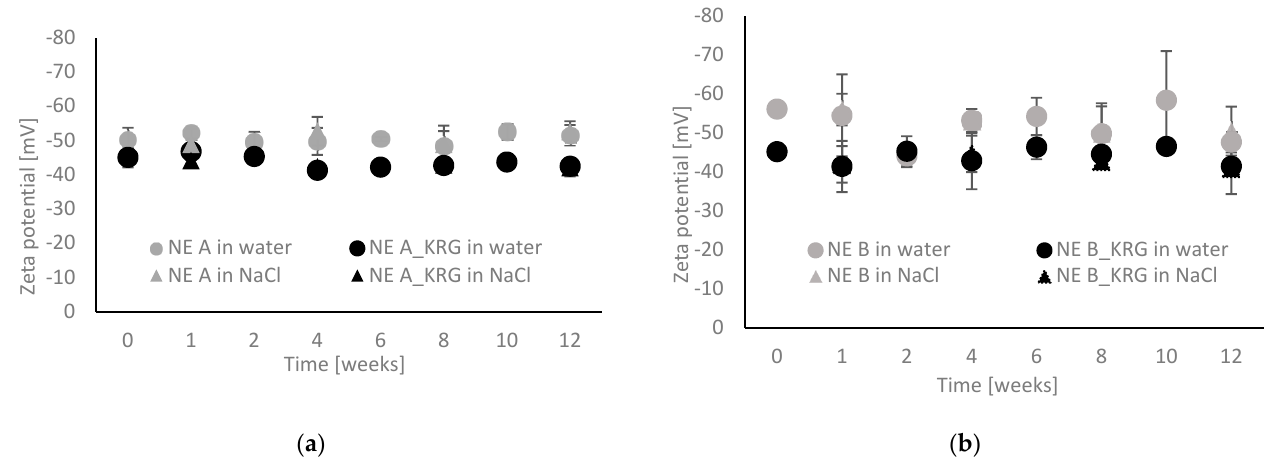
Figure 4. Zeta potential as determined by laser Doppler electrophoresis for oil-in-water nanoemul- sions with and without KRG extract. ( a ) NE type A (grey markers: NE A, black markers: NE A_KRG), ( b ) NE type B (grey markers: NE B, black markers: NE B_KRG). Samples were diluted 1:100 v / v either in purified water or electrolyte solution (0.01 mM NaCl) for comparison. Values are means ± SD of n = 3 experiments.